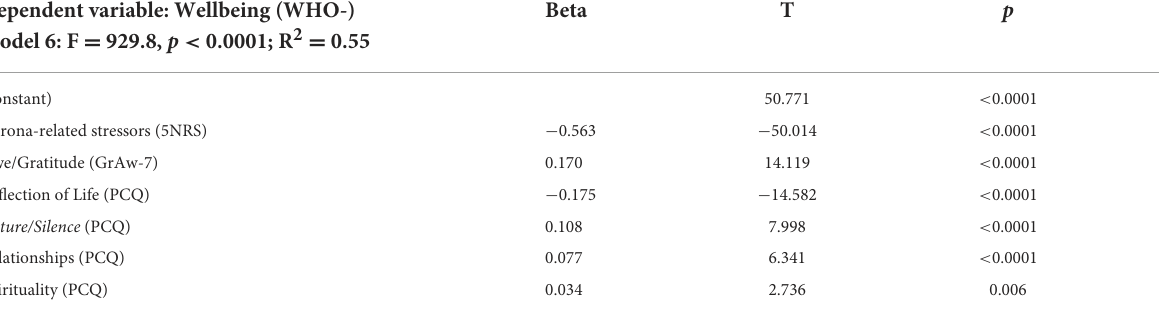
TABLE 6 Predictors of wellbeing as a dependent variable (stepwise regression